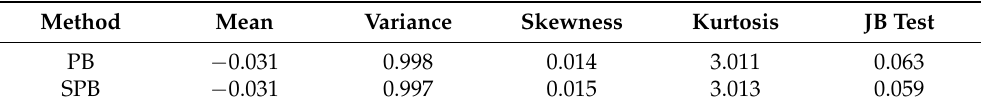
Table 5. Numerical exercise: averaged estimated moments of S ∗ computed with two bootstrap algorithms (PB and SPB). The last column contains the rejection frequencies of the Jarque–Bera test considering a nominal level of